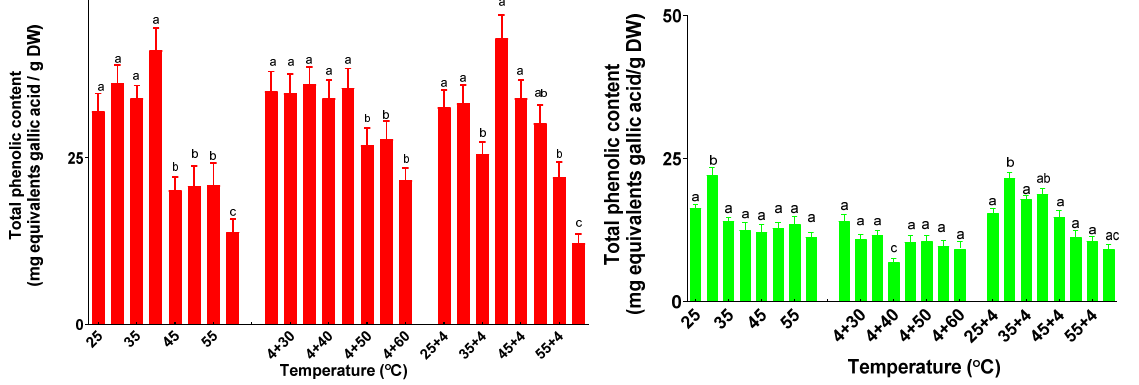
Figure 8. The total phenolic content of basil plants (red) and sage plants (green) plants subjected to different temperatures. Data sharing different letters are significantly different ( p < 0.05), while data sharing the same letters are not significantly different ( p > 0.05).